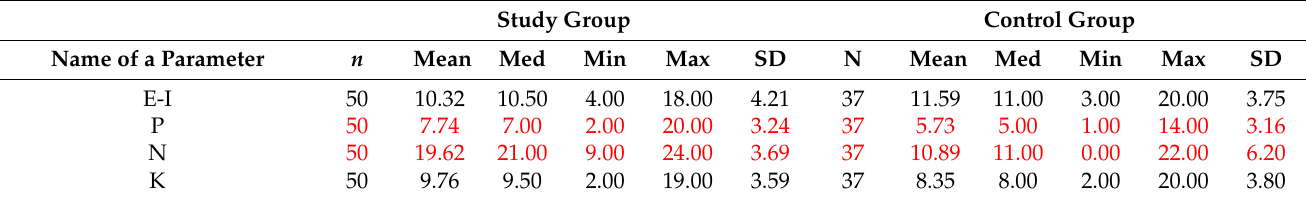
Table 5. Results of Eysenck test—study group and control group (statistically significant results marked with red